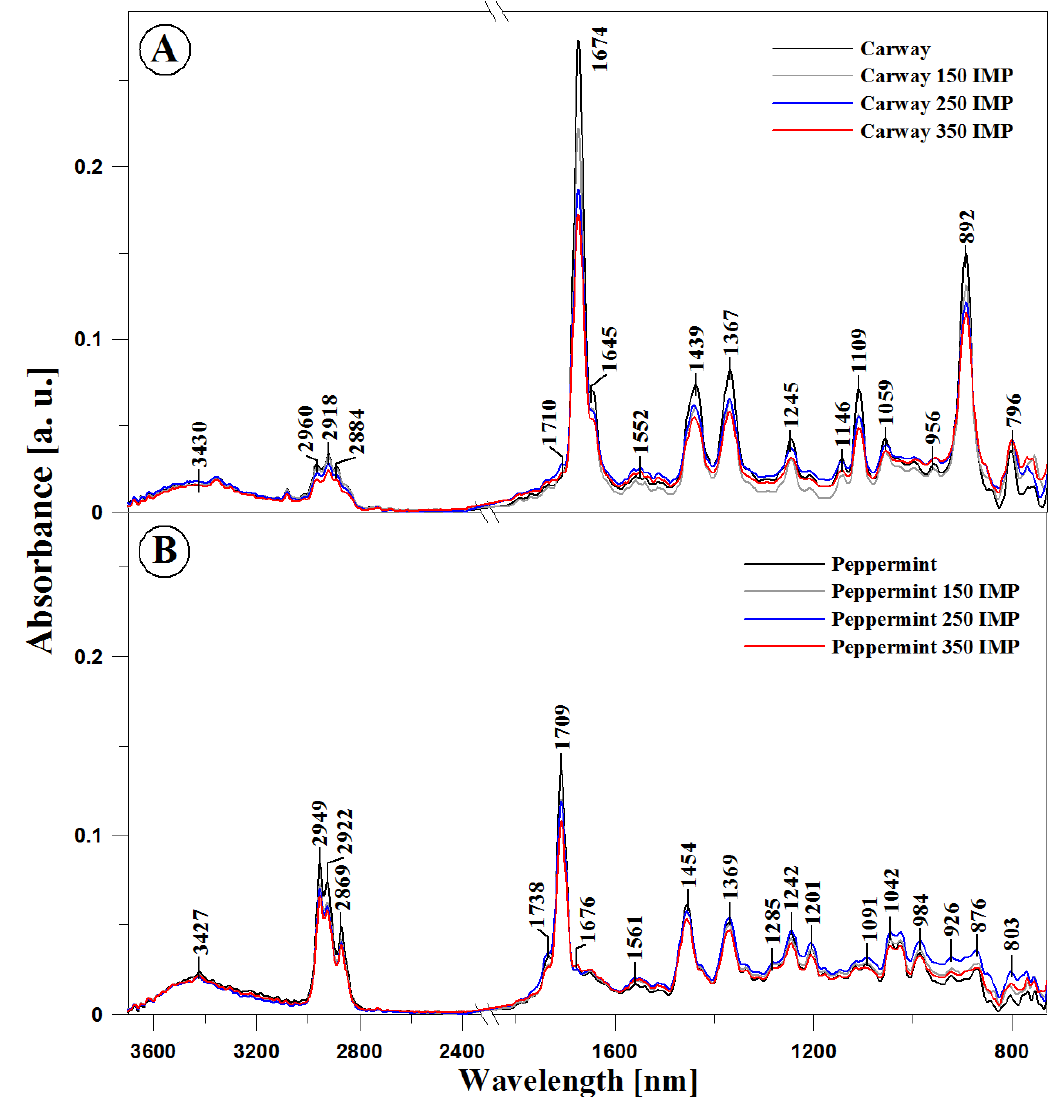
Figure 2. ATR-FTIR spectra of essential oils samples obtained from peppermint ( A ) and caraway fruit ( B ) after an application of pulsed electric field at different doses.